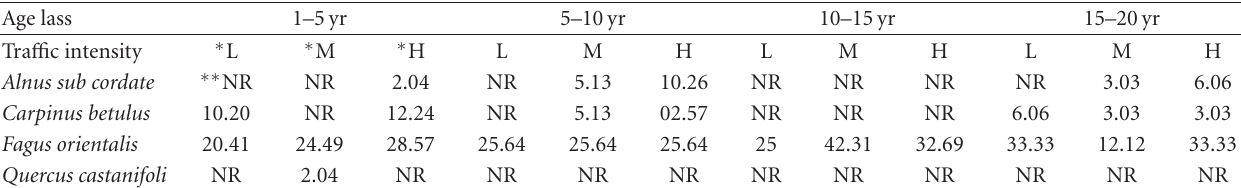
Table 9: Percentage of damaged tree species in 8 m alongside skid trail.